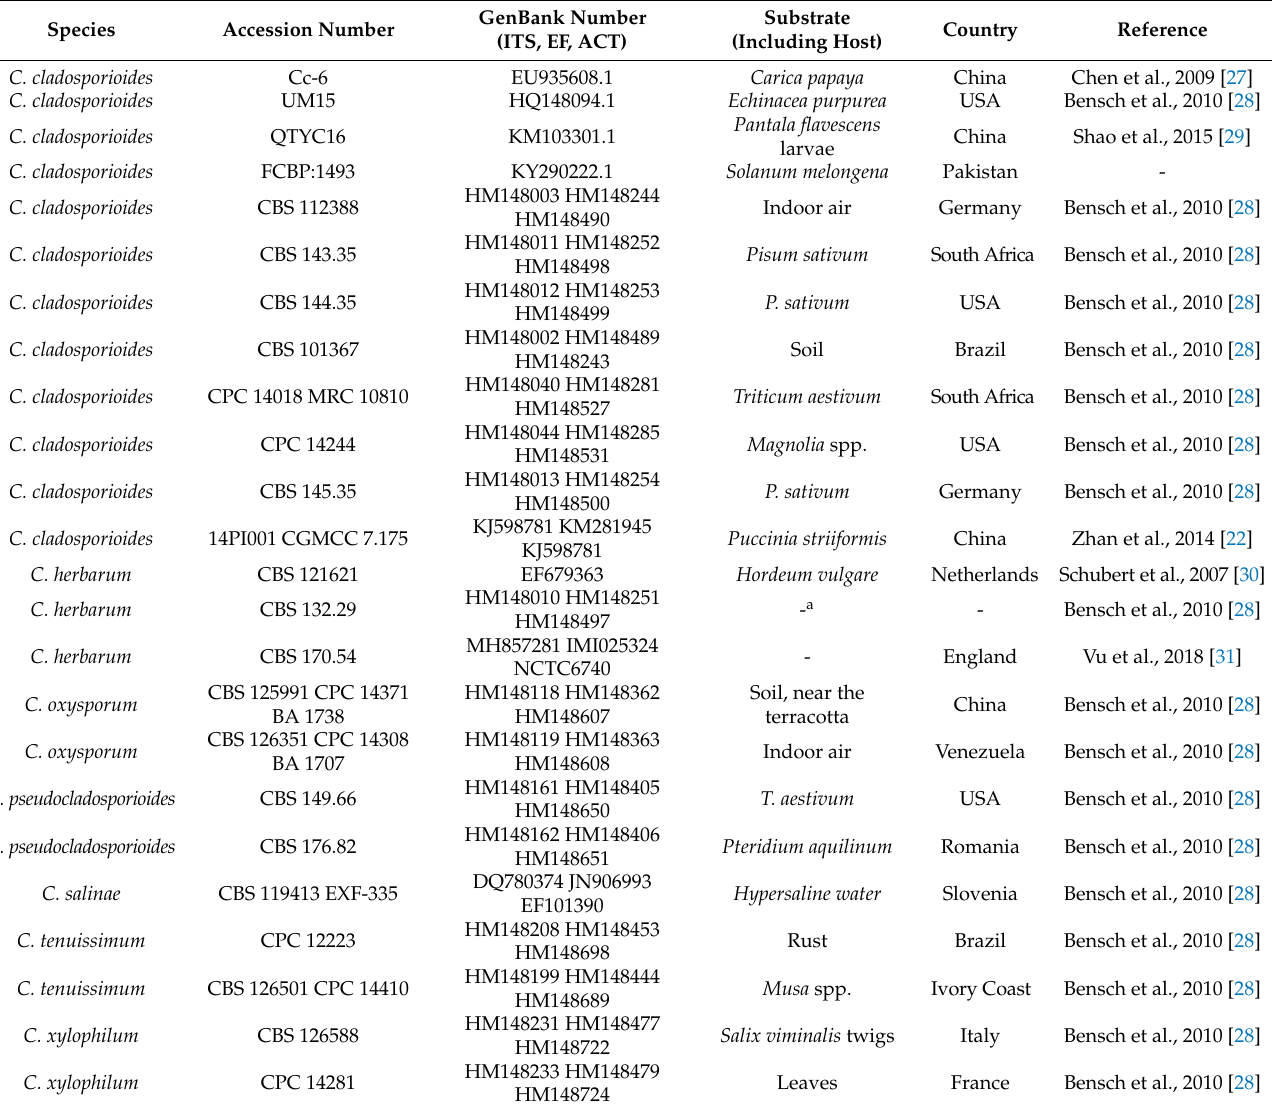
Table 1. Accession and GenBank numbers of Cladosporium species used in the molecular characteriza- tion of this